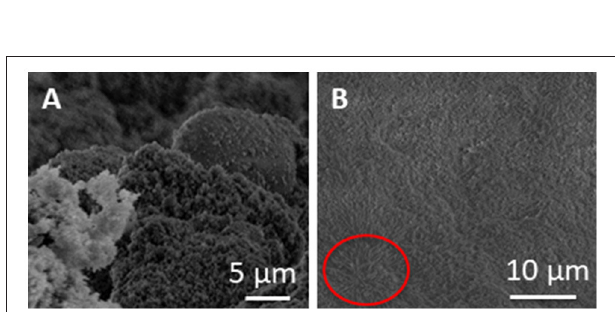
FIGURE 6 | (A,B) SEM images of SUNSPACE sample after titania nanoparticles capture, at different magnification. The circle (B) highlights the iodine salts